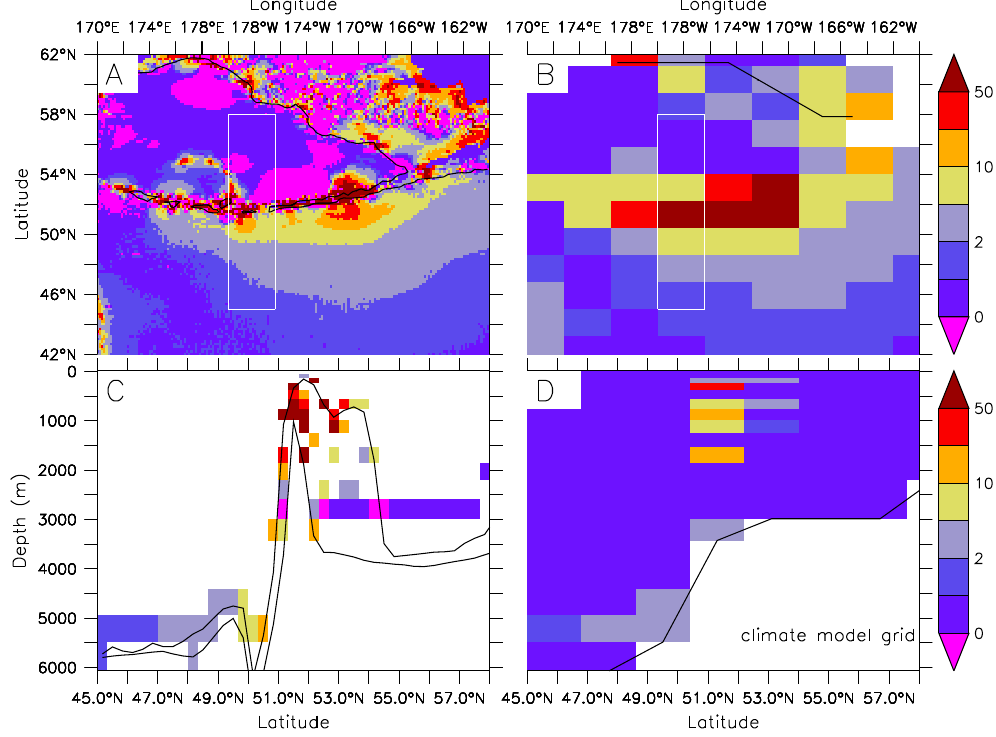
Fig. 3. Illustration of subgrid-scale scheme using the Aleutian Islands chain as an example. (A) : energy flux E (10 − 3 Wm − 2 ) out of the K1 barotropic tide from ER03. (B) : as (A) but averaged on the climate model grid. The white boxes in (A) and (B) denote a section of one climate model grid box zonal width (3.8 ◦ ) shown in (C) and (D) . Black lines in (A) and (B) show the 500m isobath from a high resolution bathymetric data set (etopo20) and the model, respectively. (C) : E from (A) averaged on a 1/3 ◦ horizontal grid of etopo20 at the corresponding levels of the climate model. On this grid there is only one level of nonzero data. Displayed are zonally averaged values of E within the white box shown in panel (A) , which leads to some latitudes having more than one nonzero values in the figure. In cases where the deepest climate model grid box is shallower than the deepest high resolution bathymetry E is shifted up on the level of the deepest climate model grid box (e.g., at 56 ◦ N). Lines show the zonal maxima and minima of the high resolution bathymetry. (D) : E from (C) horizontally averaged on the climate model grid. Model bathymetry is shown as the black line. Note that the sum over all vertical levels in (D) equals (B)